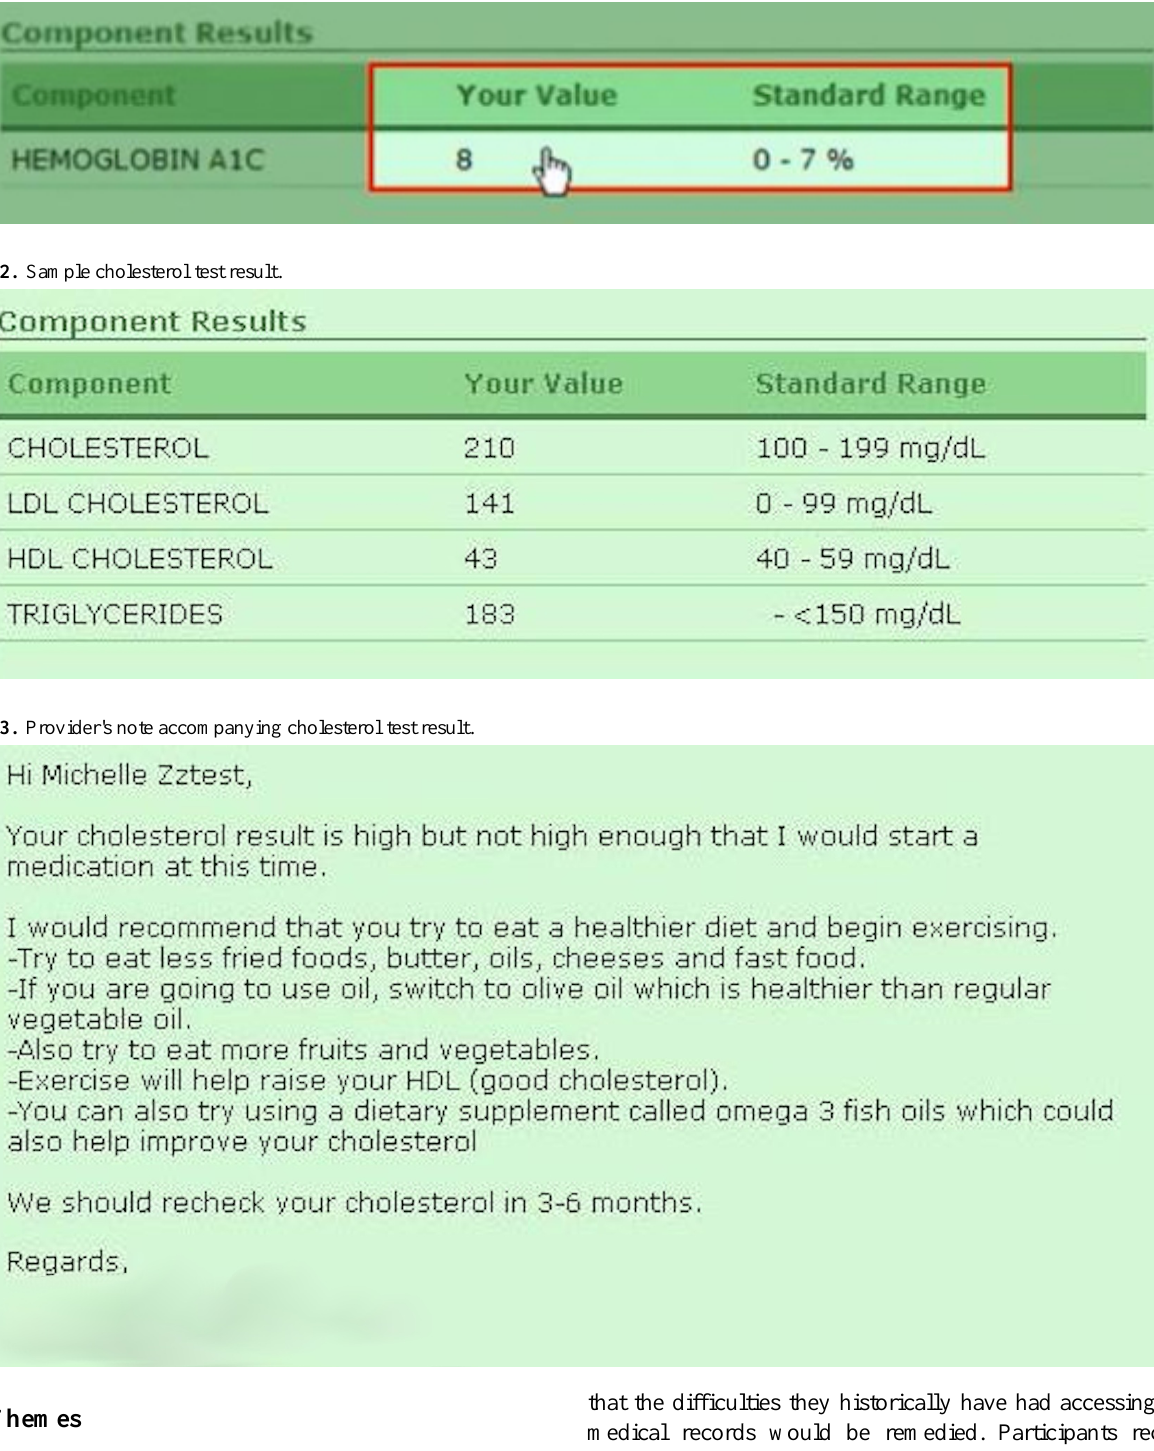
Figure 1. Sample hemoglobin test result from patient portal.